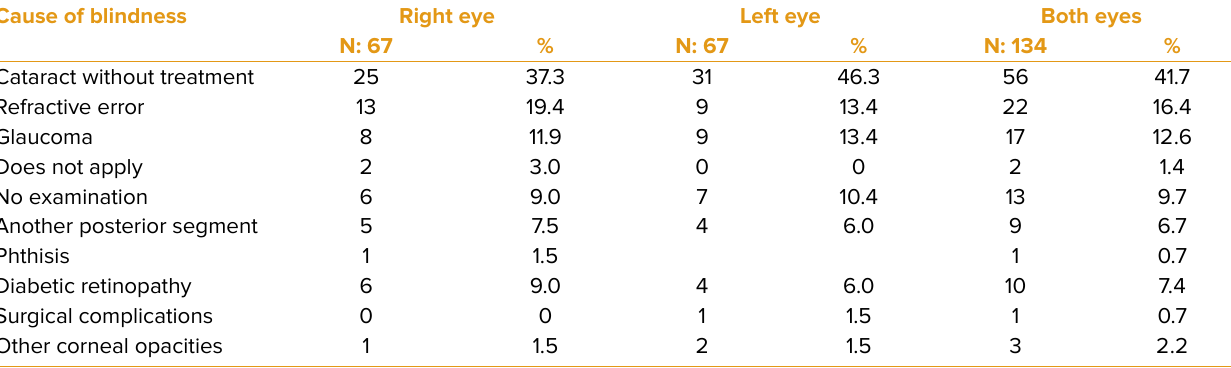
Table 4. Main causes of blindness in patients aged 50 years or older evaluated in the reference centers, Honduras,